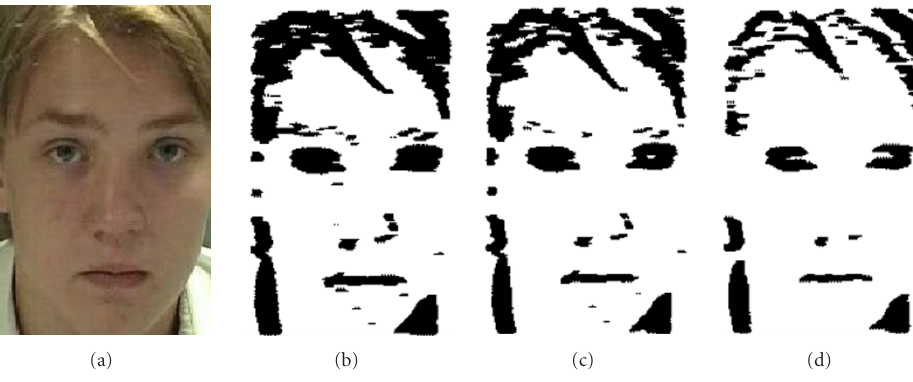
Figure 4: Red channel variation images at di ff erent scales. (a) Input image with low quality and contrast. (b) n = FaceWidth / 30, α = 1 . 4. (c) n = FaceWidth / 25, α = 0 . 6. (d) n = FaceWidth / 30, α = 0 . 6.